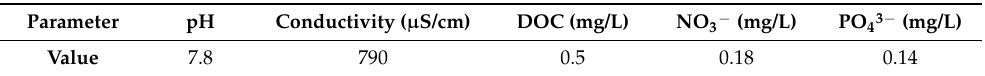
Table 2. The major characteristics of the water matrix (dechlorinated natural potable water) used for the